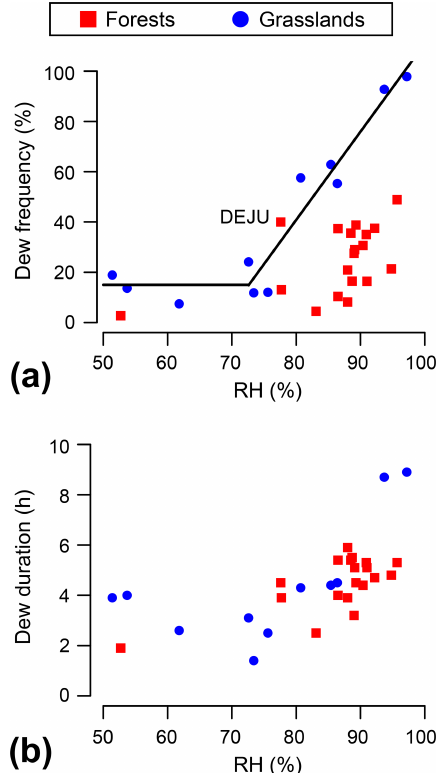
Figure 4. Dew frequency (a) and duration (b) versus RH (from 23:00 to 05:00 the next day) for each site over the growing season. The slope of 3 . 5 ( r 2 = 0 . 92) in (a) has been calculated based on the grasslands with RH > 70% only. Dew formation has been cal- culated at the top of the canopy of the grasslands and within canopy of the forests